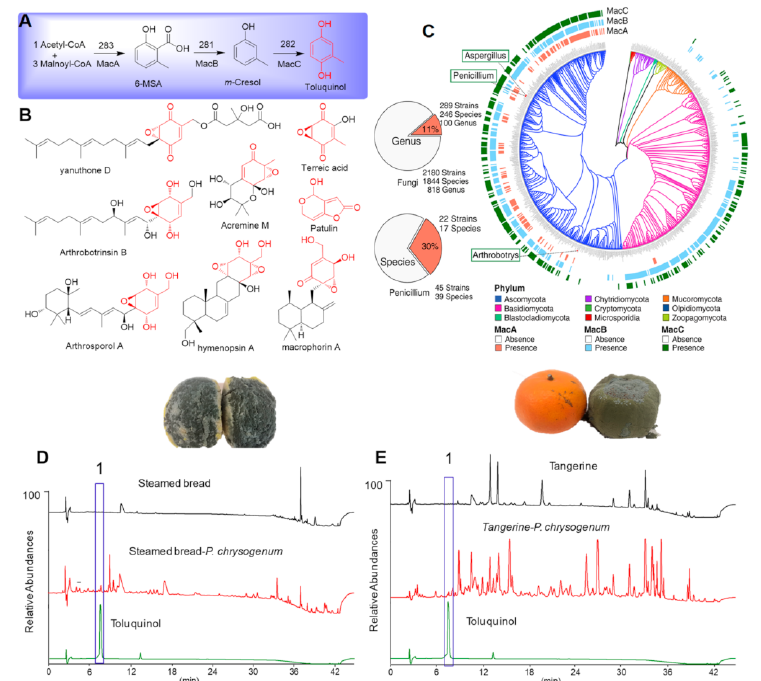
Figure 1. Biosynthesis and wide distribution of toluquinol as a key intermediate for a large number of fungal metabolites. ( A ) Biosynthetic pathway for toluquinol in fungi. ( B ) Structures of representative fungal metabolites using toluquinol as a key precursor. ( C ) Wide distribution of the key biosynthetic gene PKS for toluquinol in fungi. ( D ) Detection of toluquinol in the metabolic profile of Chinese steamed breads colonized with Penicillus species. ( E ) Detection of toluquinol in the metabolic profile of Tangerines colonized by Penicillus